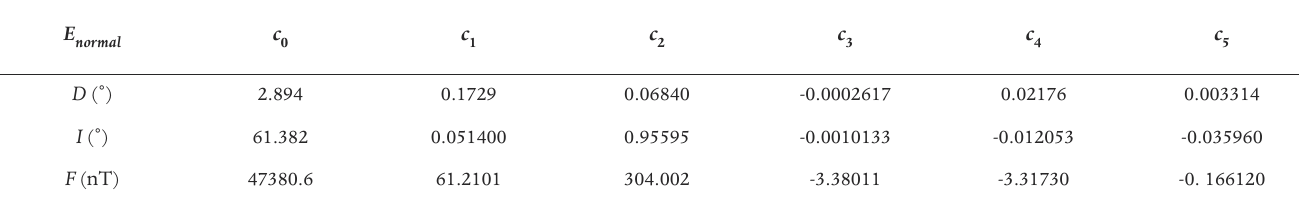
Table 4. The coefficients of the CGNRF 2008.5.